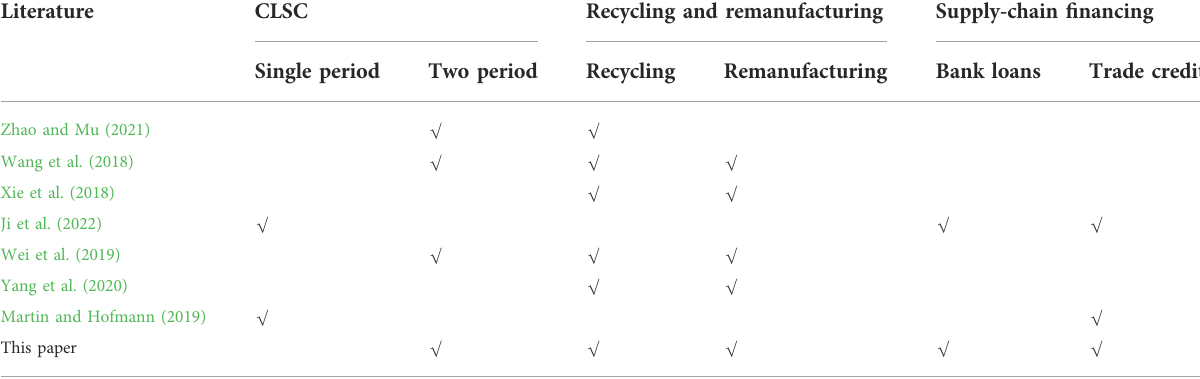
TABLE 1 Summary and comparison of this paper with related